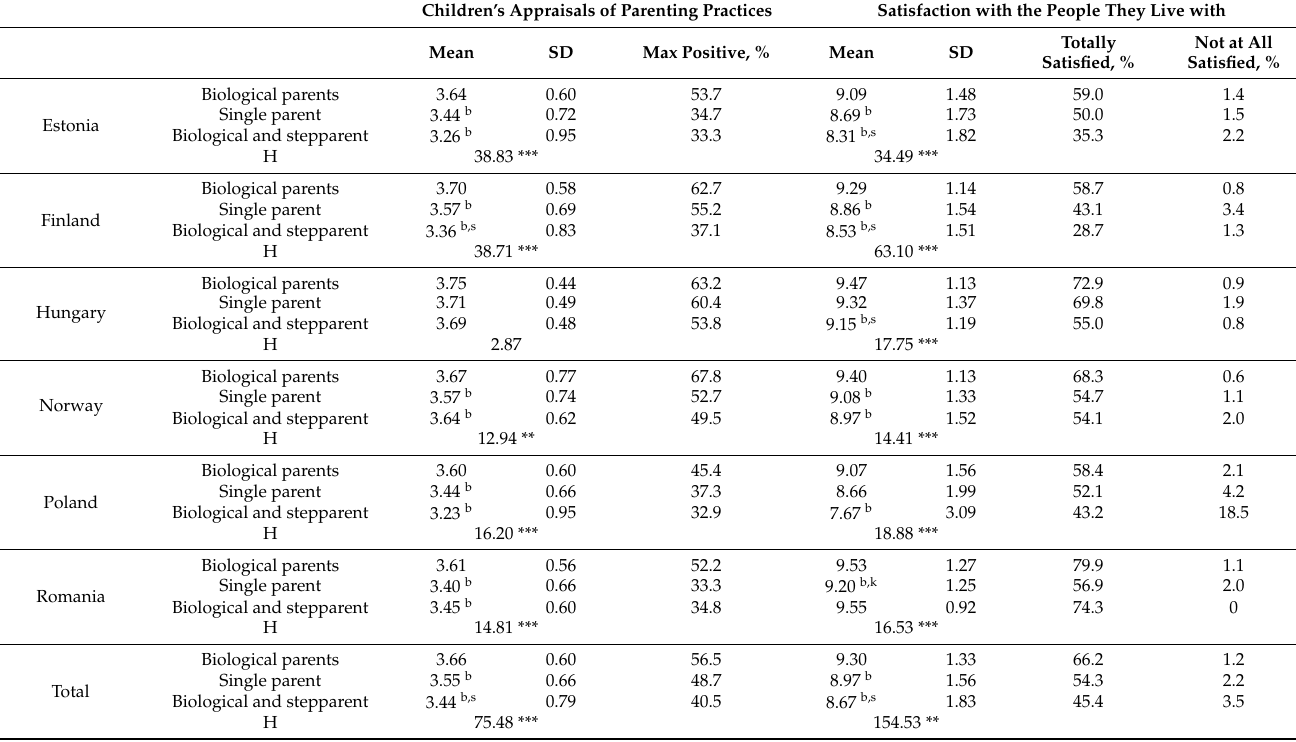
Table 2. Arithmetic mean, standard deviation (SD), share of children evaluating their parents’ parenting practices at the maximum positive level (4 on 0–4 scale), and arithmetic mean, standard deviation (SD), share of children totally (10 on 0–10 scale) or not at all (0–4 on 0–10 scale) satisfied with the people they live with by countries and in total: Kruskal–Wallis (H) and Mann–Whitney U post-hoc